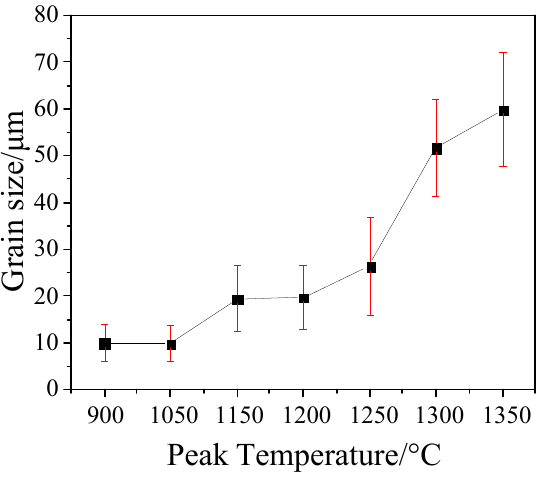
Figure 6. The change of original austenite grain size at different peak